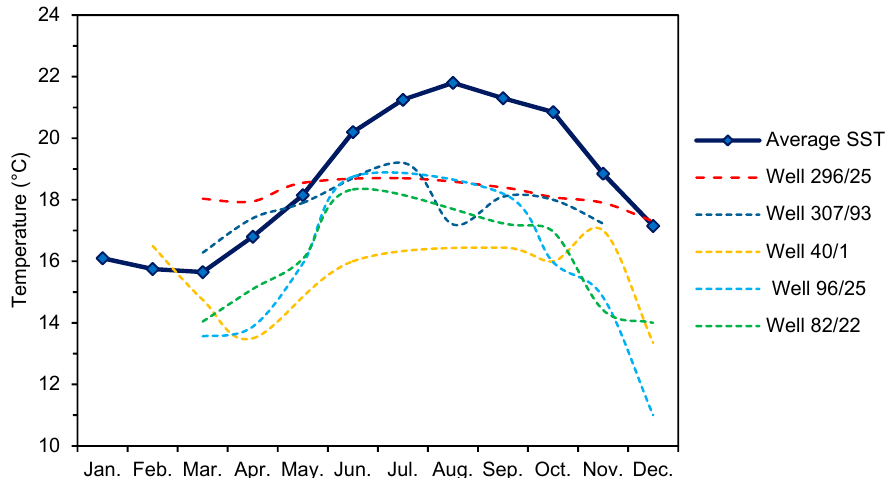
Figure 2. Comparison of groundwater average temperature values in several wells and SST measures obtained from Portuguese Institute for Sea and Atmosphere.